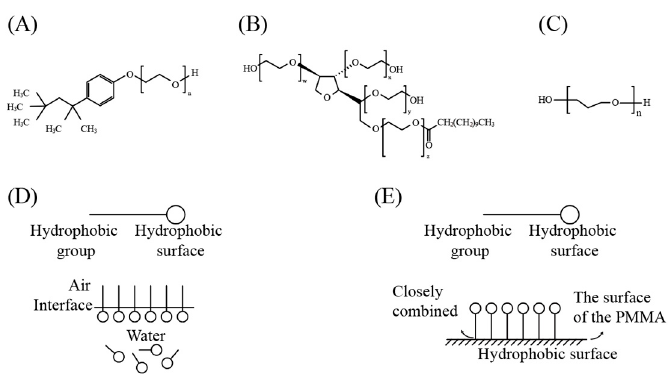
Figure 1. Chemical structural formulas and related interaction mechanism: ( A ) TritonX-100; ( B ) Tween-20; ( C ) PEG400; ( D ) arrangement mechanism of Tween-20, TritonX-100 in water; ( E ) interaction mechanism between Tween-20, TritonX-100 and the PMMA surface.